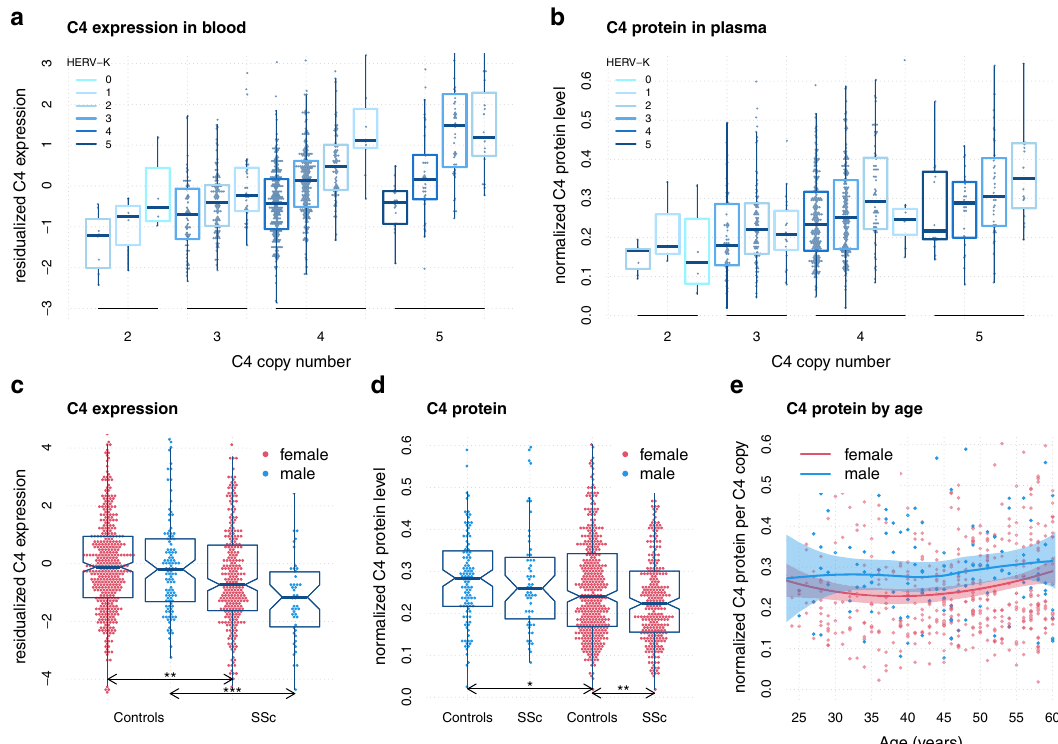
Fig. 2 C4 expression and C4 protein concentrations in whole blood. a depicts residualized total C4 expression levels by total C4 copy number (CN) strati fi ed by HERV-K CN. C4 expression is calculated as the sum of C4A and C4B expression as obtained by RNA-Sequencing. The residualized expression has been calculated by regressing out 20 (18) principal components for controls and cases, respectively. Data has been grouped by rounded C4 and HERV-K CN dosage. b depicts normalized C4 protein levels in plasma by total C4 CN strati fi ed by HERV-K CN. C4 protein levels have been normalized across 10 + laboratory sites. c depicts residualized total C4 expression levels (like in a ) for SSc and controls, strati fi ed by sex. Signi fi cant comparisons are highlighted by asterisk (* P < 0.05, ** P < 0.01, *** P < 0.001). d depicts normalized C4 protein levels (like in b ) for SSc and controls, strati fi ed by sex. Signi fi cant comparisons are highlighted by asterisk (* P < 0.05, ** P < 0.01, *** P < 0.001). e depicts normalized C4 protein levels in blood from 119 adult men (blue) and 447 adult women (red) as a function of age with locally estimated scatterplot smoothing (LOESS). Protein levels are normalized to the number of C4 gene copies in an individual ’ s genome. All boxplot are drawn with default settings in R 4.0.3: lines are de fi ned as fi rst, second and third quartile (Q1, Q2, Q3), whiskers depict the most extreme data points within Q1 – 1.5 interquartile range (IQR), and Q3 + 1.5 IQR. Boxplot notches are de fi ned as 95% con fi dence interval of the DRB1: 37SY, 58A, 74RL, 96E, and HLA-DPB1: 8, 76I, 91H, 96x) (Fig. 3d). To complement our analysis, we repeated our search for residual C4 -independent association to SSc, this time conditioning on the C4 genetic signal which was not derived from the expression dataset but from the fi rst dataset as ten independent C4 eQTL signals as described. Repeating the forward selection of AAs or classical HLA alleles conditioning on the ten fi rst dataset- derived independent C4 eQTLs signals resulted in four indepen- dent AAs from HLA-DPB1 (9F, 76I, 91H, 96x) or fi ve independent alleles ( HLA-DRB1 : *11:04 and HLA-DBP1 : *13:01, *26:01, *28:01, *30:01) (Supplementary Fig. 4D, E) supporting the role of HLA- DRB1 and HLA-DPB1 as a C4 -independent association.